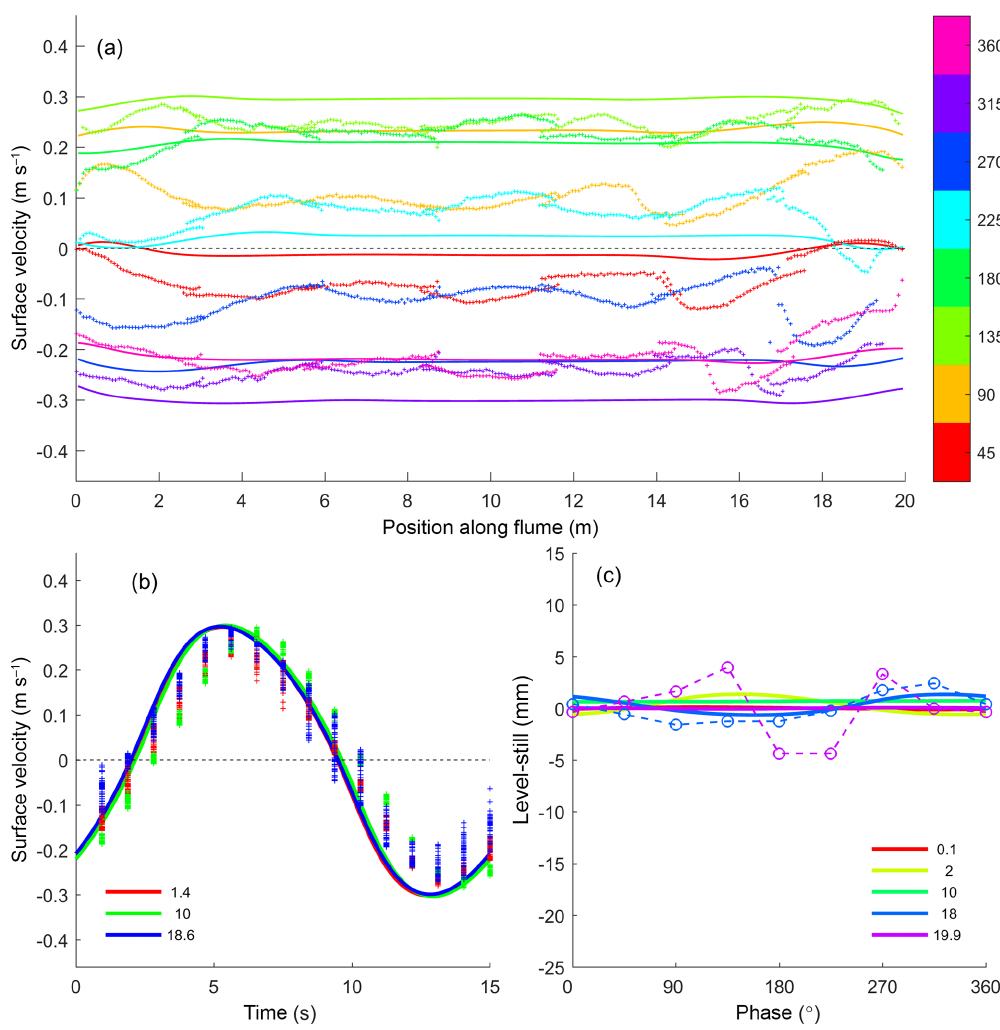
Figure 7. Flow data from PIV and modelled flow with 15s period tilting at 0.009mm − 1 slope amplitude with both boundaries open. (a) Flow velocity at the water surface along the flume for selected phases of the tidal cycle. (b) Flow velocity at the water surface in one tidal cycle for selected positions along the flume measured from x = 0m, indicated in the legend. (c) Water level as a function of phase in the tidal cycle for selected positions along the flume. Measured water levels have correct amplitude and phase but possibly erroneous vertical offsets. Data are plotted as symbols and model results are plotted as drawn